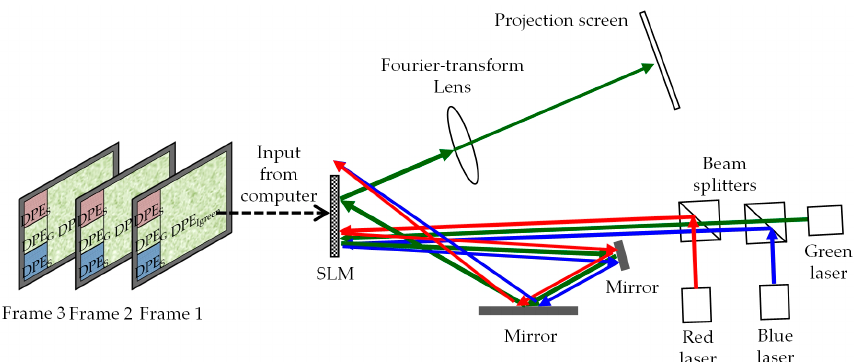
Figure 1. Schematic diagram of the diffractive projection display system. When a green image is produced, for example, the green laser beam becomes rectangular as it reflects back to the spatial light modulator (SLM). The diffractive phase element, DPE Igreen , in sub-window W I modulates the rectangular beam and produces a display image in the projection screen. The red and blue beam- shaping DPEs diffract the laser beams away from the window W I . Using temporal integration of multiple speckled images reduces the speckle effect in the display